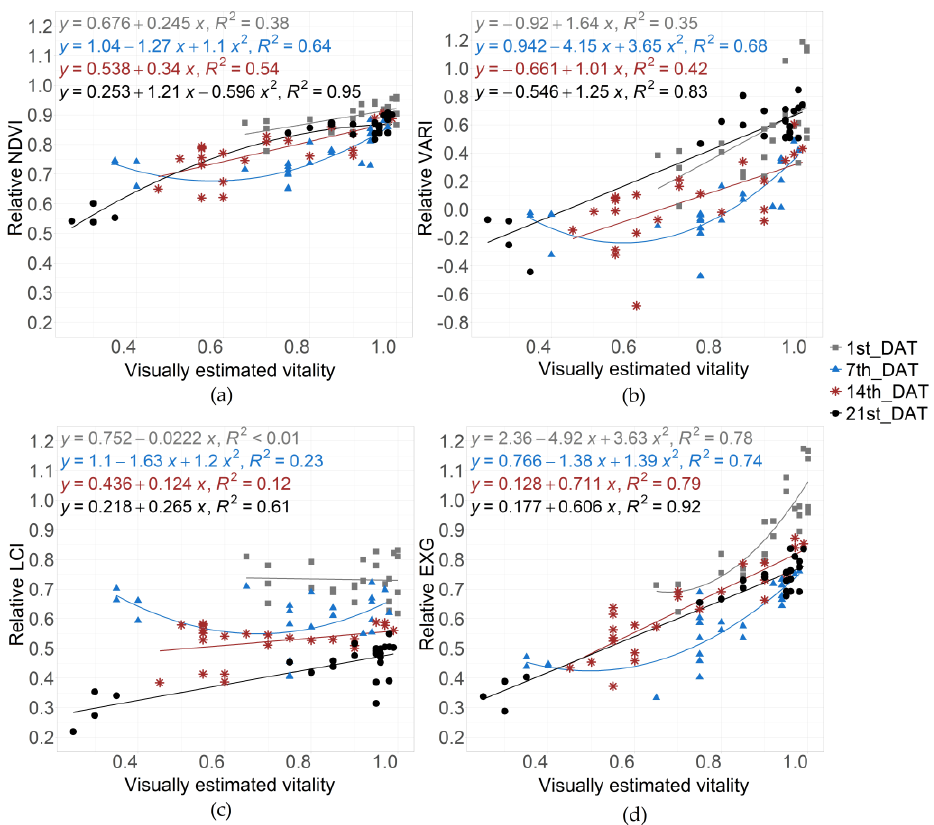
Figure 8. ( a – d ): Relationship between VIs (relative values compared with before application) and visually estimated vitality in 2019. Linear and polynomial regression analysis ( p < 0.05).